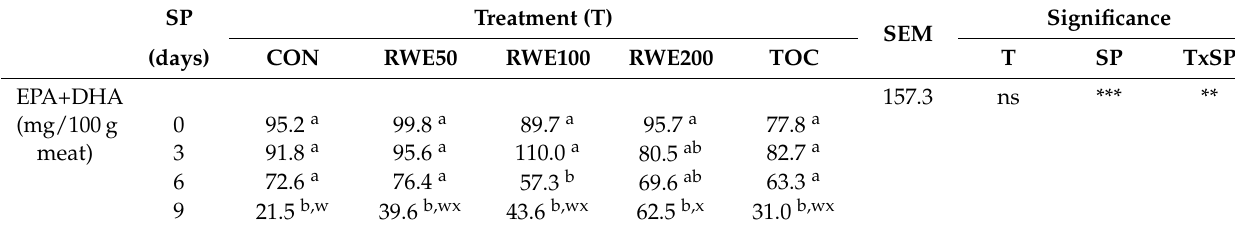
Significance SEM